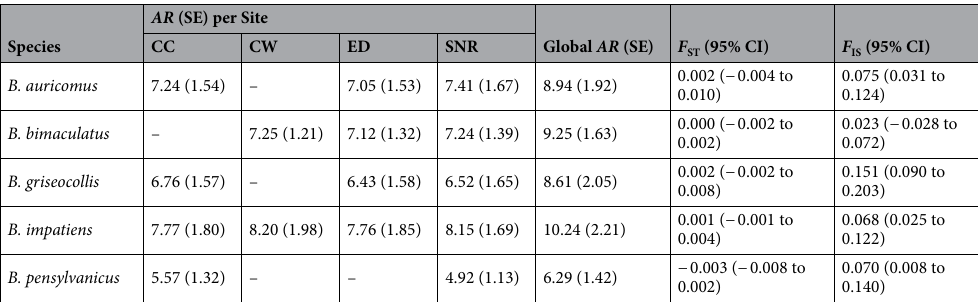
Table 3. Population genetic statistics for bumble bees ( Bombus spp.) in the greater Saint Louis region. Allelic richness ( AR ), calculated as mean allele number across loci, is calculated per species for each site and combining all sites (i.e., global AR ). F ST describes population genetic differentiation. F IS is the inbreeding coefficient. All populations with < 25 successfully genotyped individuals following quality control measures were removed from population genetic analyses. SE standard error, 95% CI 95% confidence interval, CC Calvary Cemetery, CW Castlewood State Park, ED EarthDance Farms, SNR Shaw Nature Reserve.